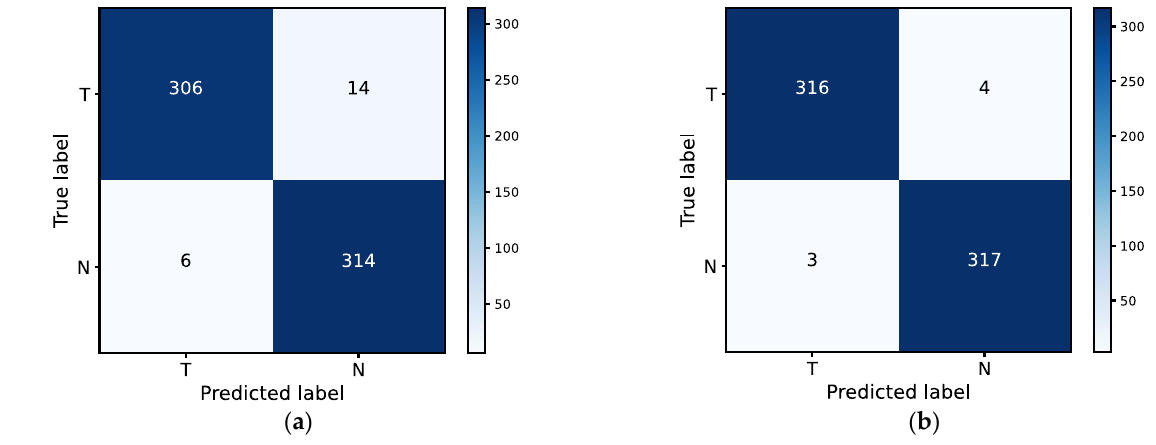
Figure 14. Confusion matrix ( a ) ParNet; ( b ) improved ParNet.